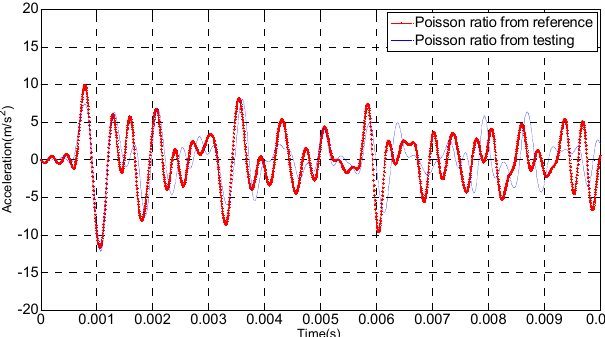
Figure 19. Poisson’s ratio influences on wave behaviour in orthotropic material model.